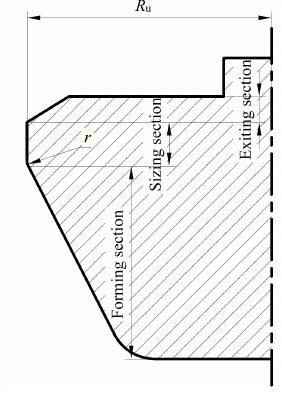
Figure 4. Axial section of upper